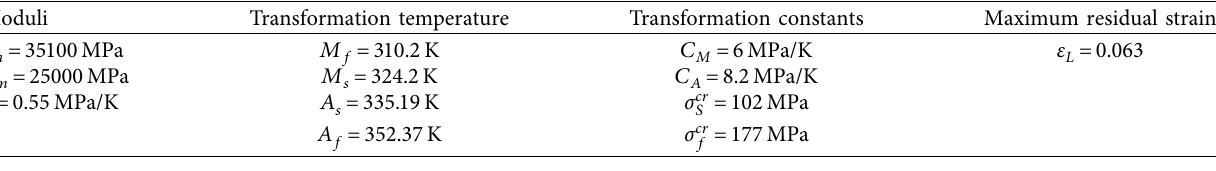
Figure 11: SMA stress-strain curve at different temperatures. Table 2: Material parameters of SMA.